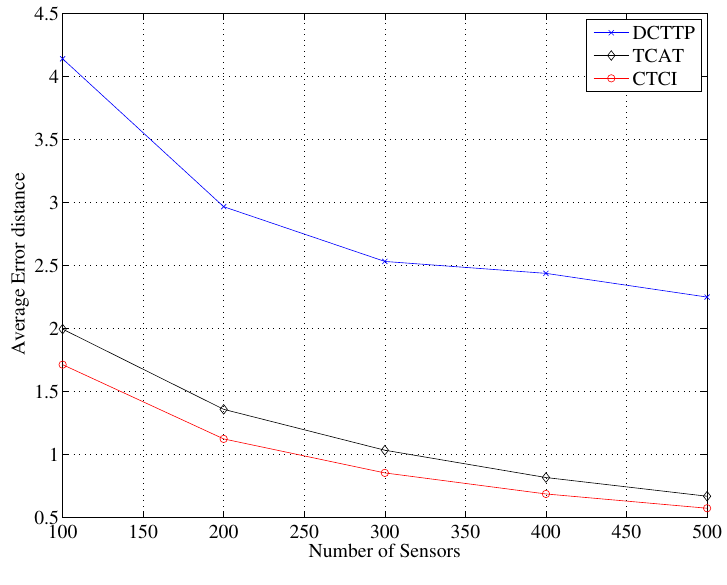
Figure 14. Impact of the number of sensor nodes on average error